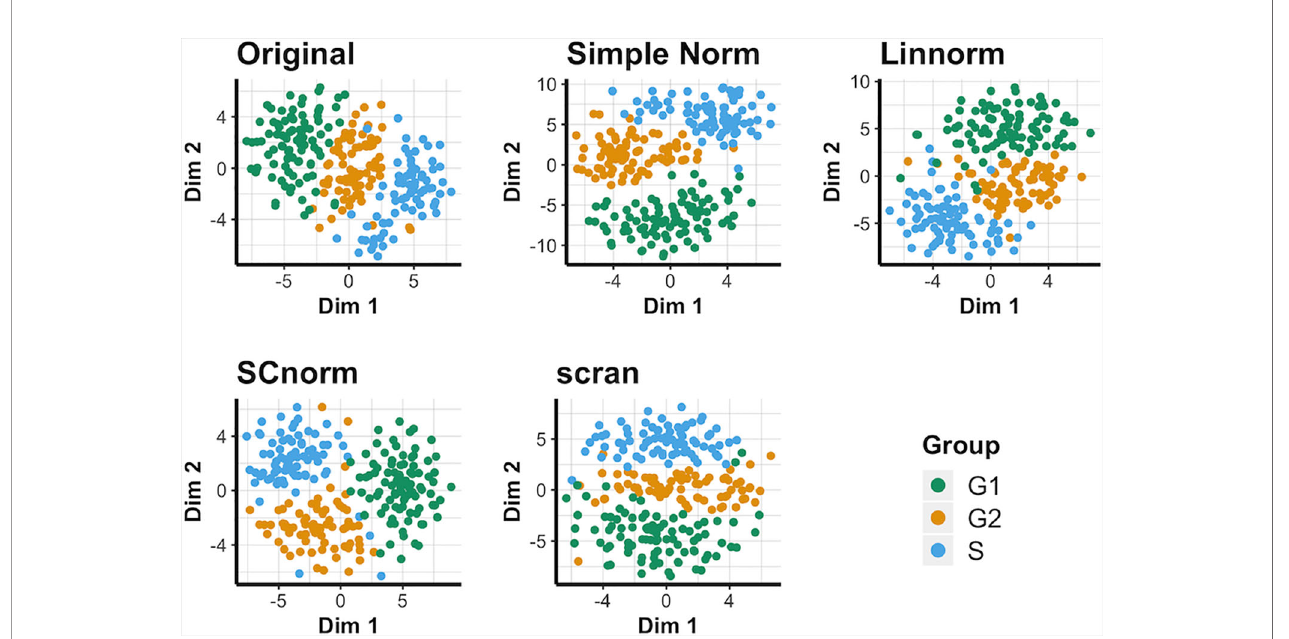
FIGURE 4 | t-SNE plots for the human embryonic data under various normalization